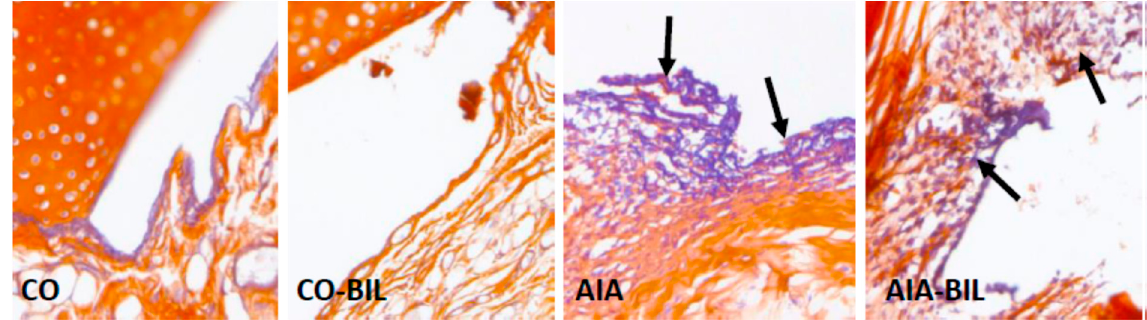
Figure 7. Detection of fibrin in joints with Mallory’s phosphotungstic acid hematoxylin (PTAH) staining. Massive exudation of fibrin (arrow pointing at blue color) in the inflamed joints (AIA) was reduced by UCB treatment (AIA-BIL). CO—control group, CO-BIL—control group administered with UCB 200 mg/kg of body weight daily i.p. from day 14, AIA—group with adjuvant induced arthritis, AIA-BIL—group with adjuvant induced arthritis administered with UCB 200 mg/kg of body weight daily i.p. from day 14. PTAH, 200×.